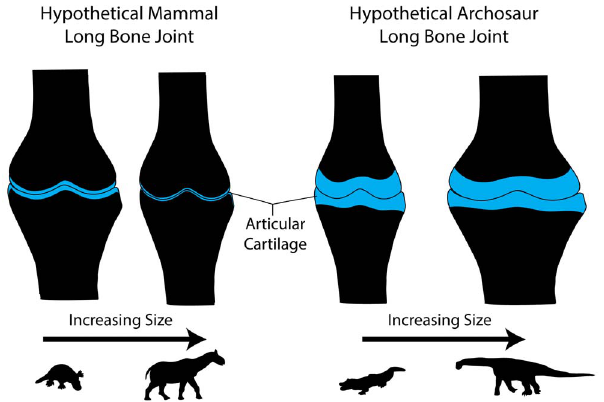
Figure 7. Schematic representation of changing joint surfaces and articular cartilage thickness with increasing size in mammals and archosaurs. Our data suggest that as mammals increase in size, the joint region narrows and the articular cartilage becomes relatively thinner, producing convex and well-developed subchondral bone surfaces. For archosaurs, our data suggest that with increasing size the joint region expands while the articular cartilage remains thick, producing relatively flat and less convex subchondral bone surfaces.